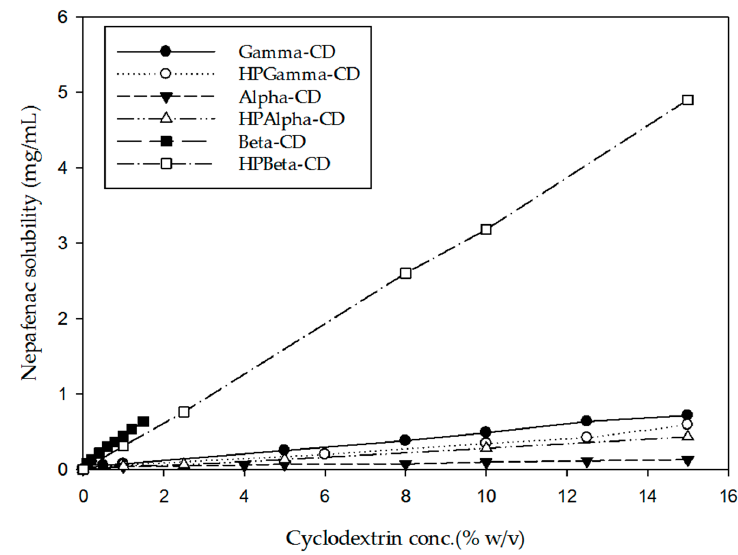
Figure 2. Phase-solubility profile of nepafenac in aqueous solution in combination with different CDs.